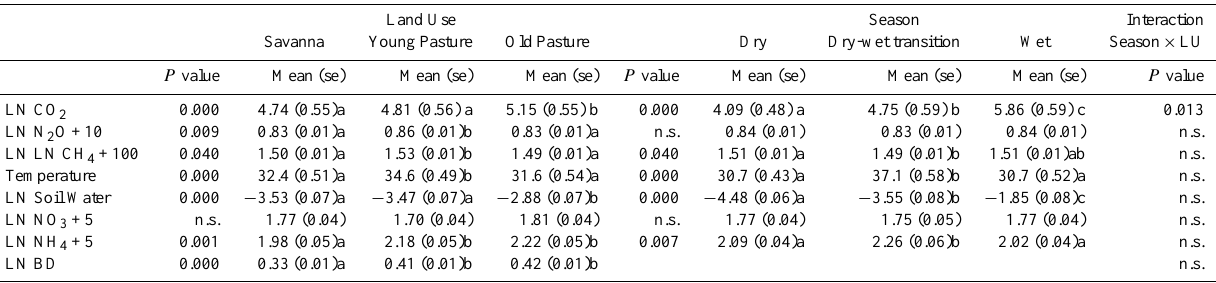
Table 2. The effect of land use and seasonality on soil gas fluxes and environmental properties, as determined by 2-way ANOVA with LSD post-hoc analysis. Values followed by different letters are significantly different from one another. Non-normally distributed data were transformed as indicated.